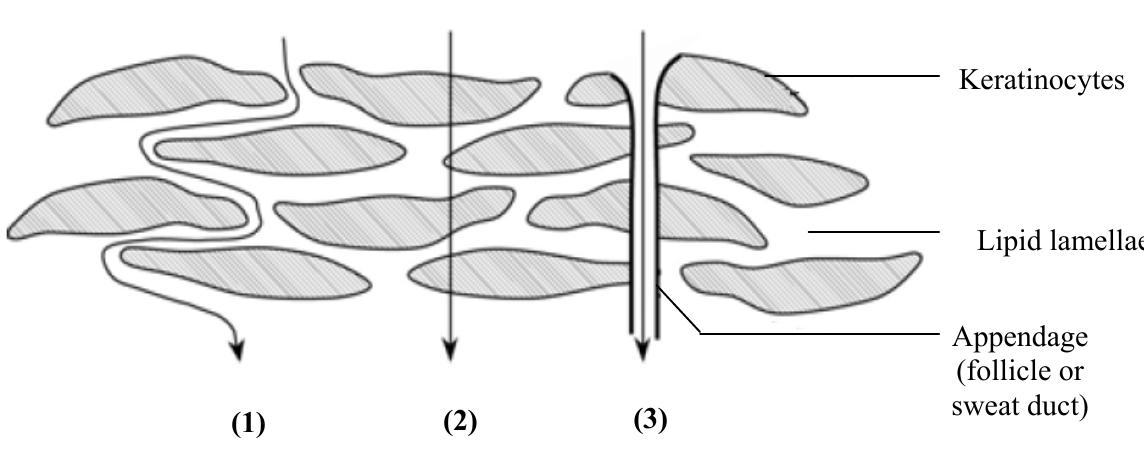
Figure 1. Drug permeation routes across the skin: ( 1 ) intercellular diffusion through lipid lamellae; ( 2 ) transcellular diffusion through the keratinocytes and lipid lamellae; and ( 3 ) diffusion through appendages such as the hair follicles and sweat glands (with permission from